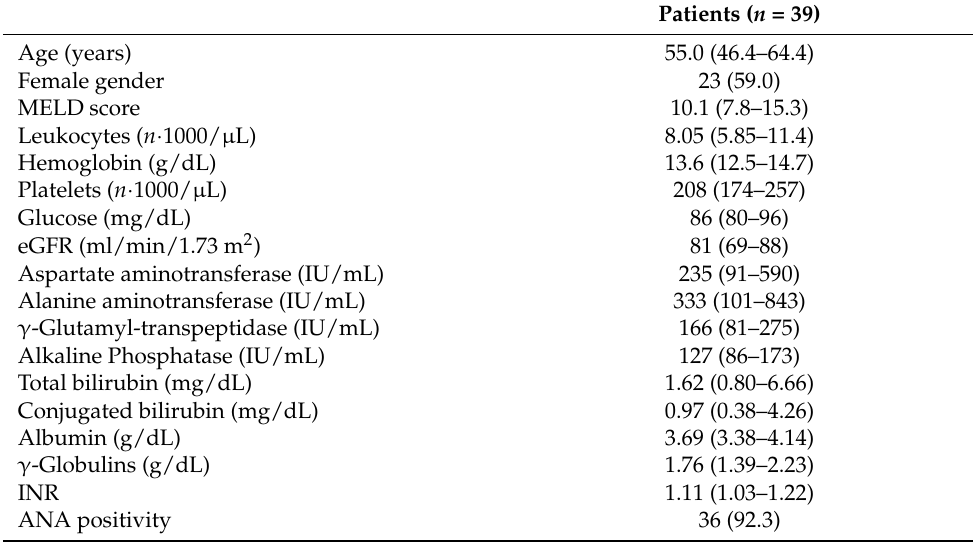
Table 1. Baseline demographic and biochemical characteristics of the studied population. Categor- ical variables are reported as frequencies (%), and continuous variables are reported as medians (interquartile